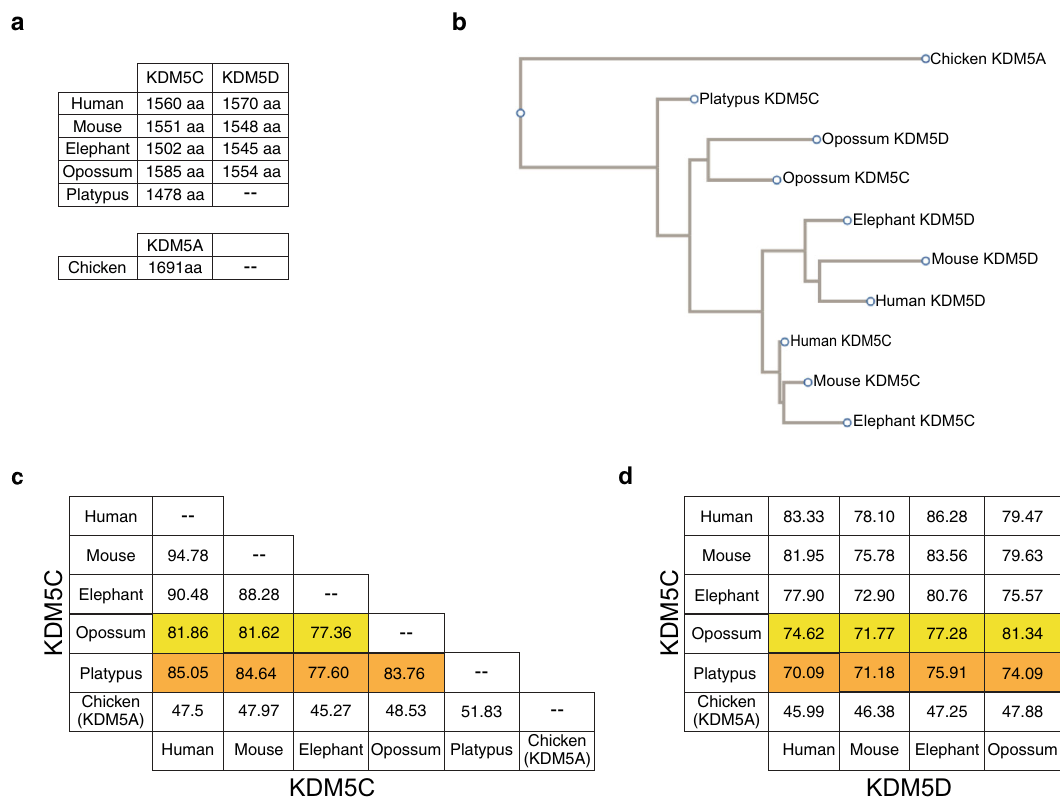
Fig. 7 Divergence of KDM5C/D proteins during mammalian evolution. a Amino acid chain length of the KDM5C and KDM5D proteins. b Multiple sequence alignment phylogeny of KDM5C/KDM5D amino acid sequences using a neighbor-joining algorithm 101 . c , d Percent amino acid identity between therian, opossum, and platypus KDM5C proteins ( c ) and between KDM5C and KDM5D proteins ( d